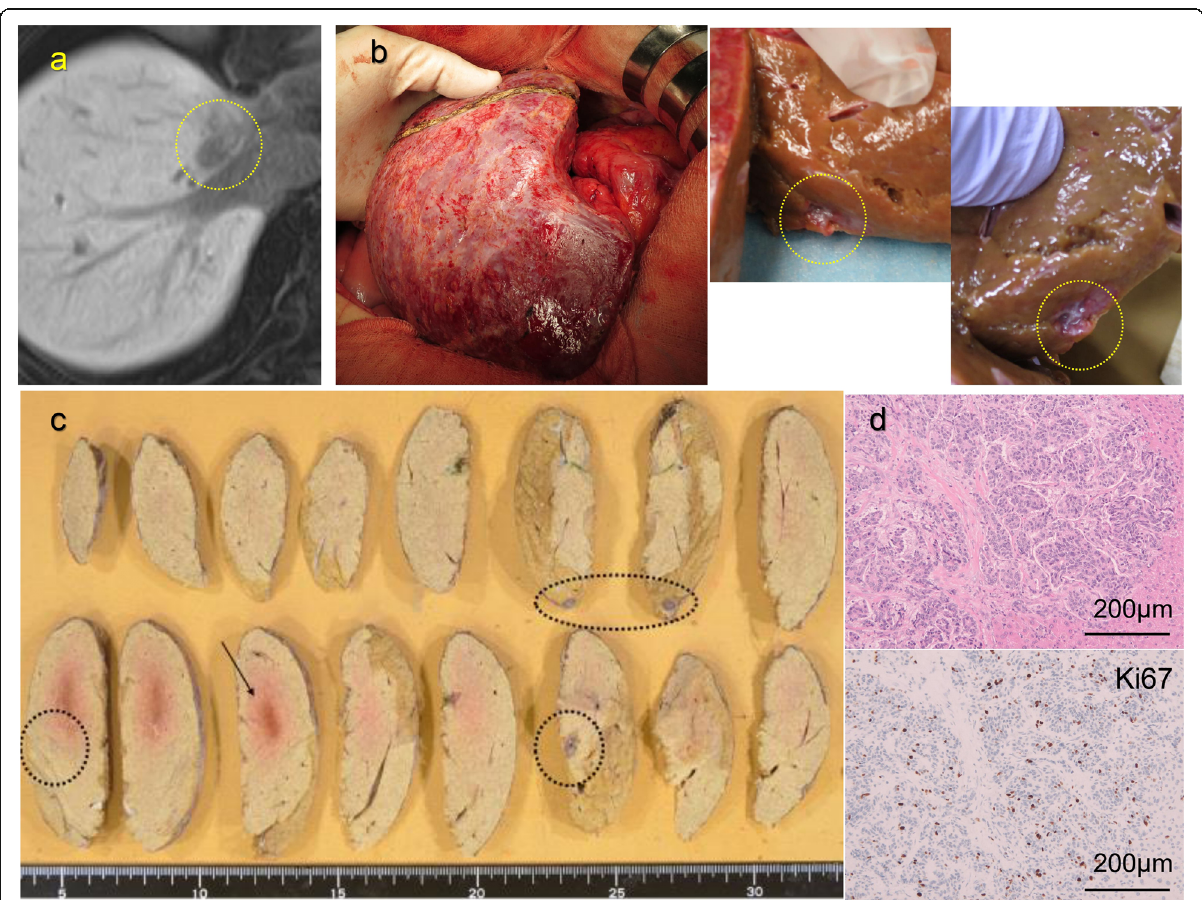
Fig. 3 Second operation. a CT detected a liver metastasis as a recurrence of NET. b Intraoperative findings showed another metastasis. c Pathological findings showed four tumors in the resected specimen. The dotted circles represent the metastases newly detected by CE-IOUS or pathological findings. The arrow points the metastasis detected before operation. d Histopathological findings were almost the same as the specimen from the last